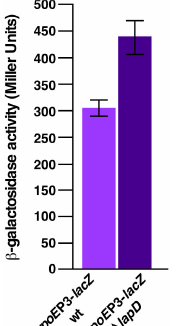
Figure 11. The absence of LapD causes the constitutive induction of the LPS defects responsive rpoE P3 promoter, even under permissive growth conditions. Exponentially grown wild type and its ∆ lapD derivative carrying the single-copy chromosomal rpoE P3- lacZ fusion were analyzed for the β -galactosidase activity. Bacterial cultures were adjusted to an OD 595 of 0.05 and allowed to grow at 30 ◦ C. Aliquots of samples were taken to measure the β -galactosidase activity. Error bars represent an S.E of three independent